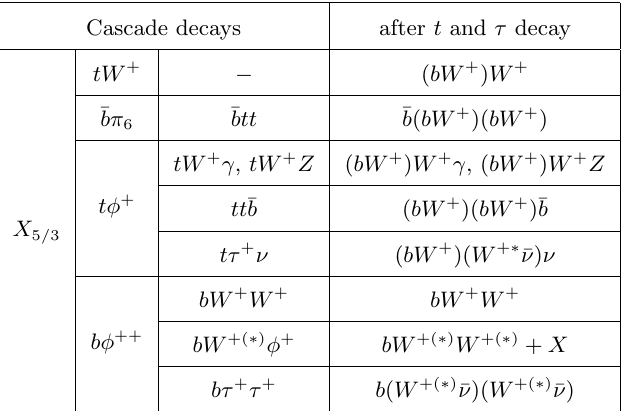
Table 1 . Possible decay channels of X . In the right-most column, we indicate the (cid:12)nal state 5 = 3 after t and (cid:28) decays in order to underline their similarity. W (cid:3) denotes o(cid:11)-shell W bosons while W ( (cid:3) ) denotes W bosons which are on- or o(cid:11)-shell, depending on the mass spectrum. The decay products of (cid:30) + always contain one W +( (cid:3) ) , and we label the (cid:12)nal state of the decay chain X 5 = 3